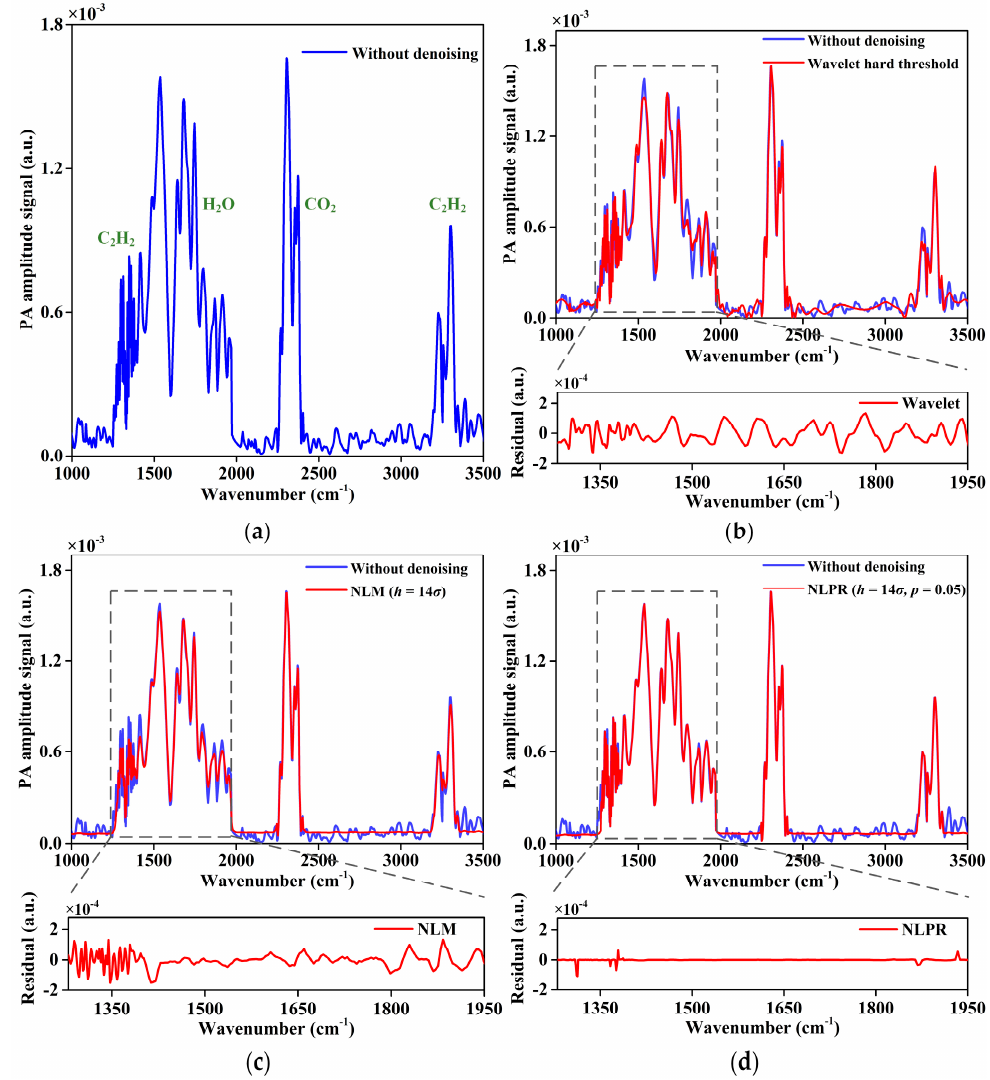
Figure 8. ( a ) Multi − component PA spectrum based on the DFTIR − PAS without denoising. ( b ) Top: denoised PA spectrum using the wavelet hard threshold method with the optimized parameters (“sym14”, “sqtwolog”, 6). Bottom: absorption peak residuals between wavelet denoised result and raw data. ( c ) Top: denoised PA spectrum using basic NLM with h = 14 σ . Bottom: absorption peak residuals between NLM denoised result and raw data. ( d ) Top: denoised PA spectrum using NLPR with p = 0.05 and h = 14 σ . Bottom: absorption peak residuals between NLPR denoised result and raw data.